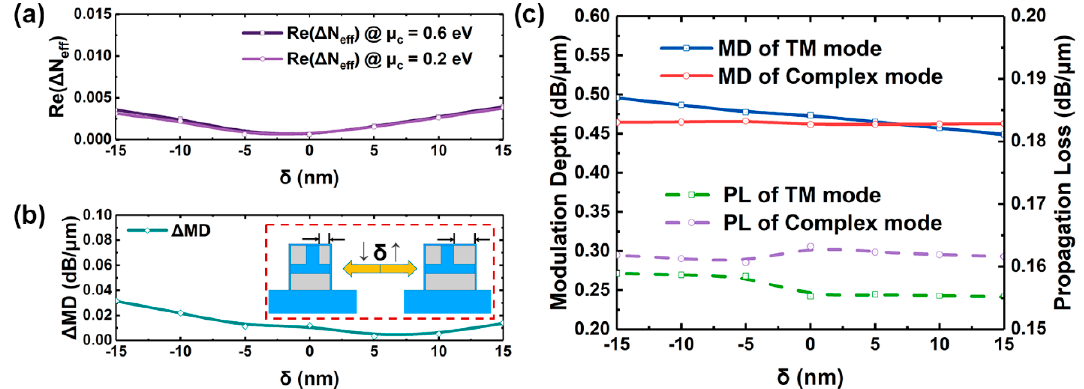
Figure 14. The inequality of the top Ag strip δ on (a) Re( Δ N eff ); (b) Δ MD; and (c) MD, PL of the TM mode and complex mode. The illustration in (b) shows the unequal condition of the DBOSW modulator, when δ < 0 the width of the right Ag stripe is smaller than that of the left one.